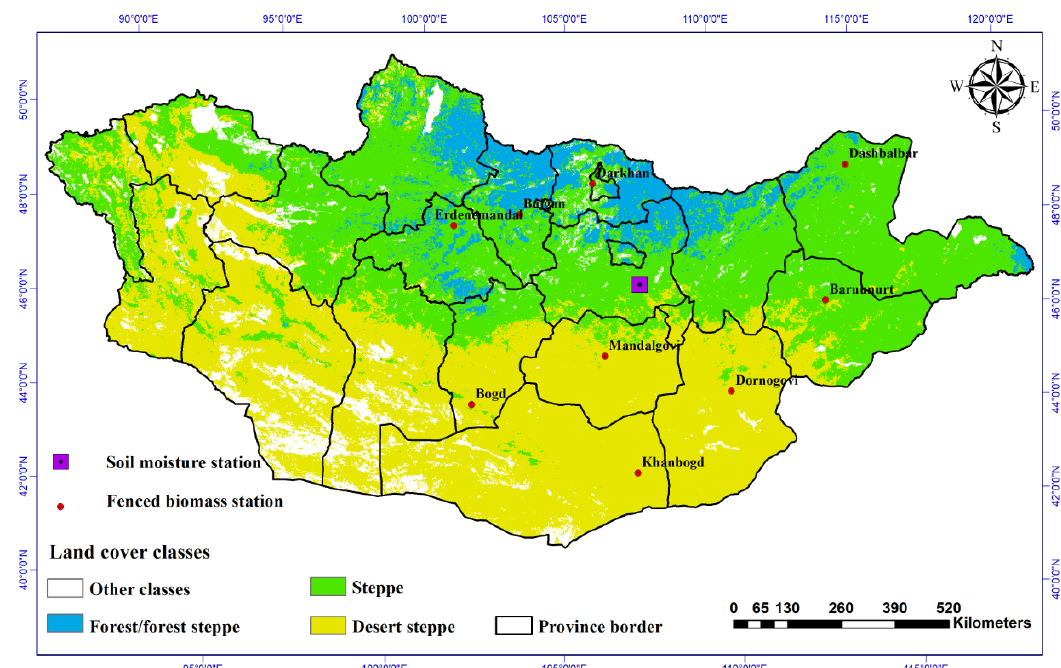
Figure 1. Study area and field station distribution.